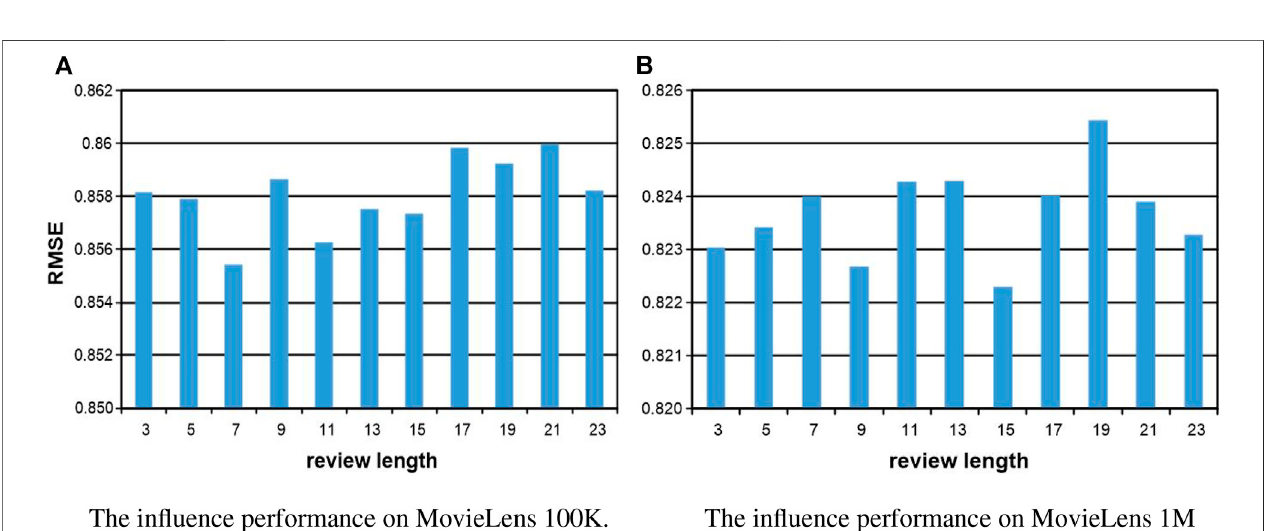
Frontiers in Genetics |